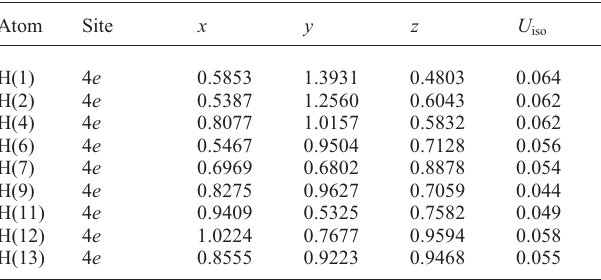
Table 2. Atomic coordinates and displacement parameters (in Å 2 )